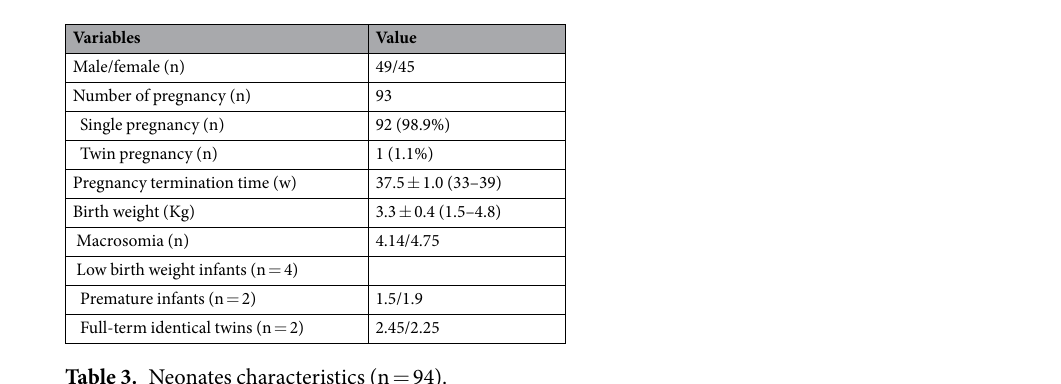
Table 3. Neonates characteristics (n =